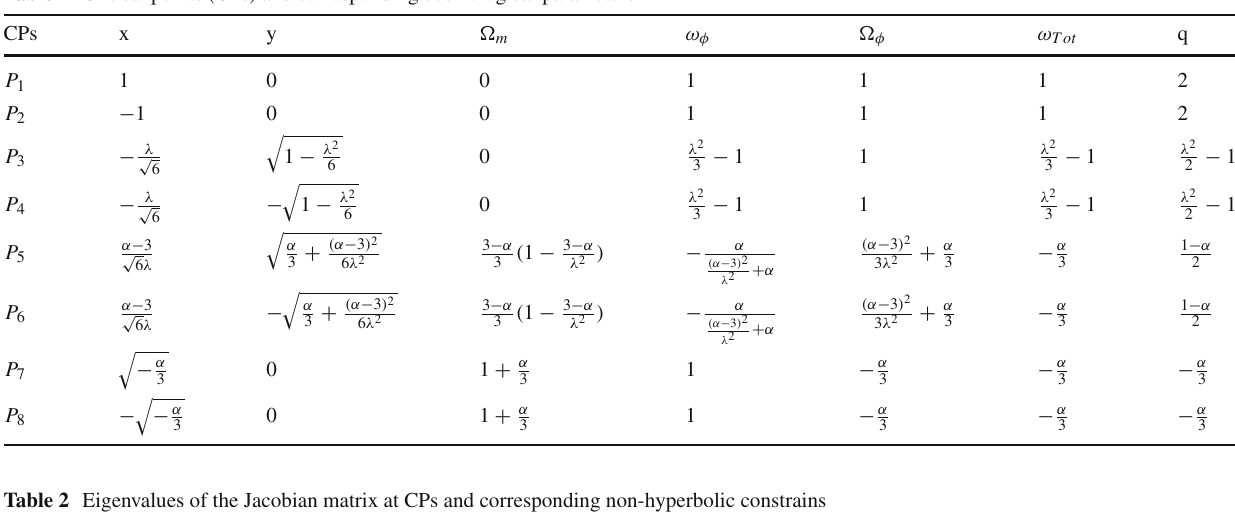
Table 2 Eigenvalues of the Jacobian matrix at CPs and corresponding non-hyperbolic constrains CPs λ